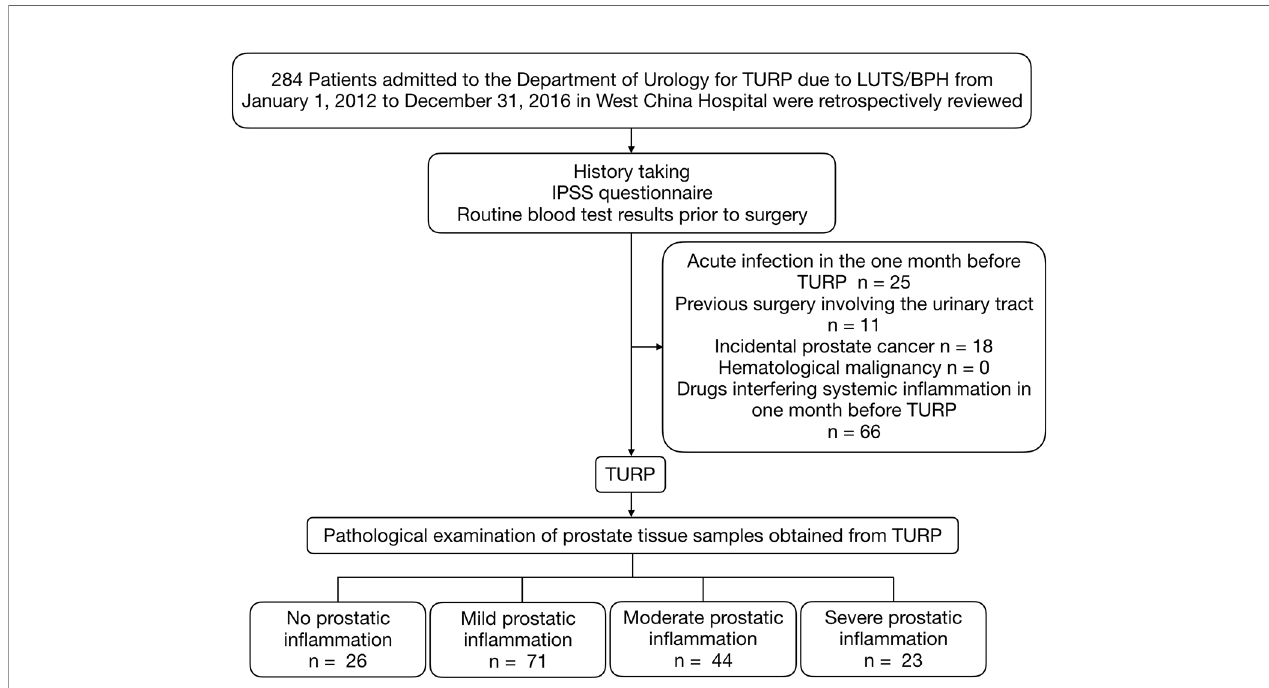
FIGURE 1 | Patients selection process. TURP, transurethral resection of the prostate; IPSS, International Prostate Symptom Score; LUTS/BPH, lower urinary tract symptoms secondary to benign prostatic